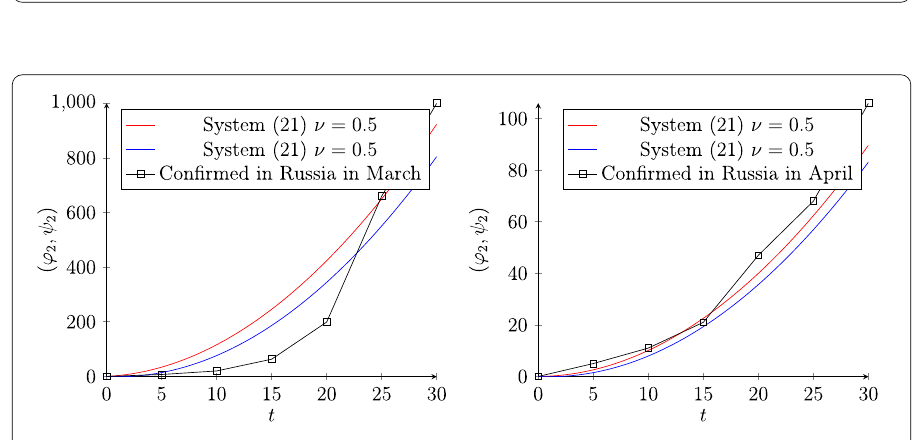
Figure 2 The dynamic evolution of system (21) when ν = 0.5, with the approximate solution by fractional Chebyshev polynomials ( ϕ 2 , ψ 2 ) = ( 2( t +2 t 2) π , 2( t +2 t 2) π ) for Russia in March and April, respectively. In March the number of infections was per person, while in April it was per K (thousand). The connection coefficient in March is C 0.5,2 = 0.79, while in April it is C 0.5,2 = 0.099